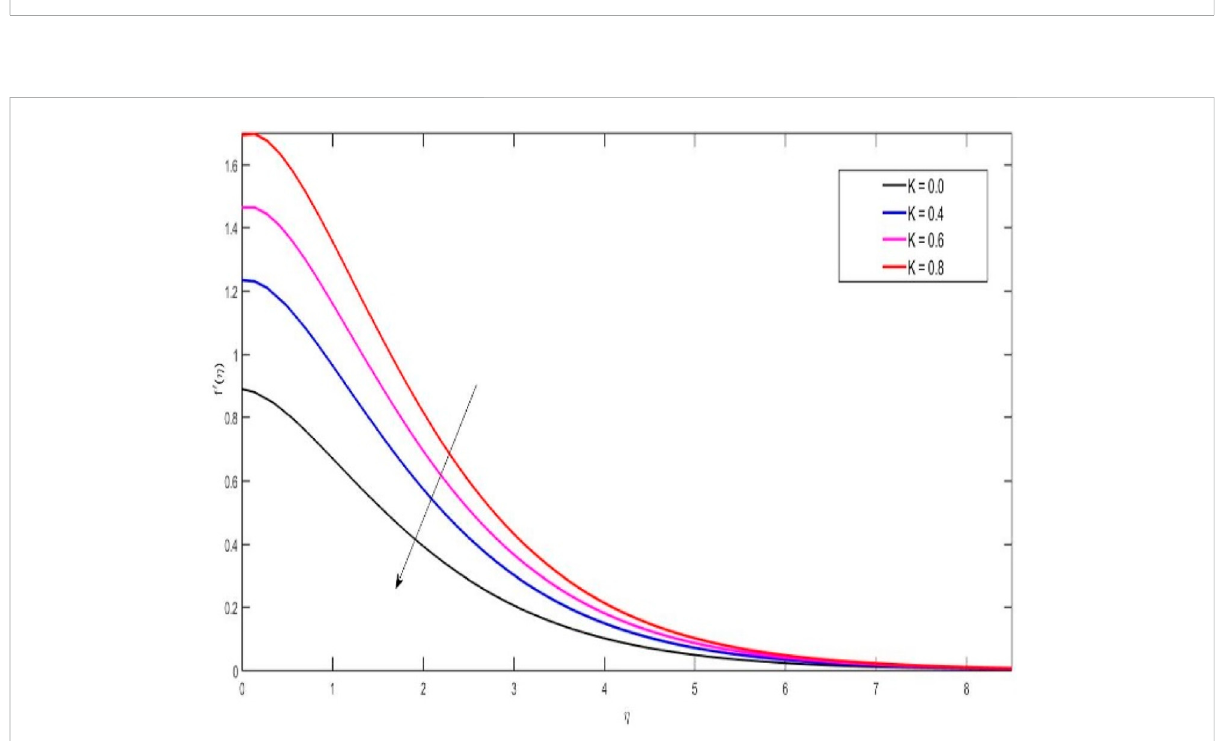
FIGURE 4 Velocity pro fi le against change in porous